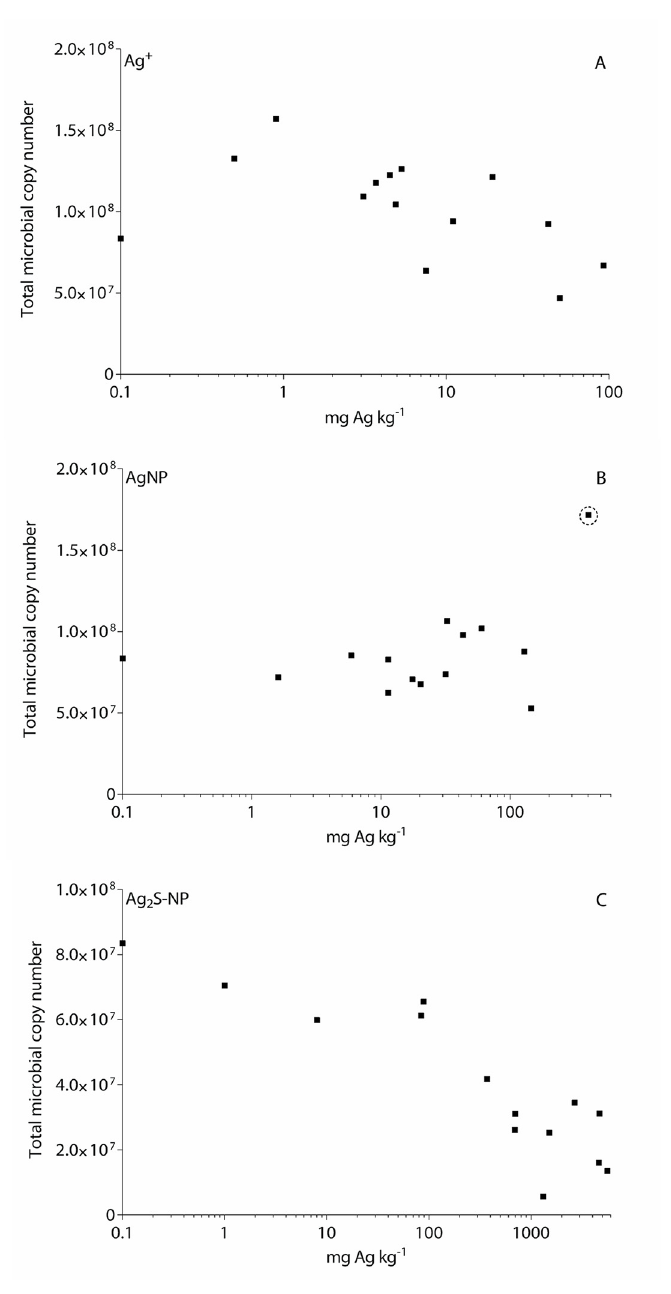
Fig 4. The abundance of bacteria and archaea, as indicated by the number of 16S ribosomal DNA (rDNA) copies measured using quantitative PCR (qPCR). Results are shown for each Ag treatment: (A) ionic Ag (Ag + ), (B) Ag nanoaparticles (AgNP) and (C) Ag sulfide nanoparticles (Ag 2 S-NP). A likely outlier is circled in the AgNP